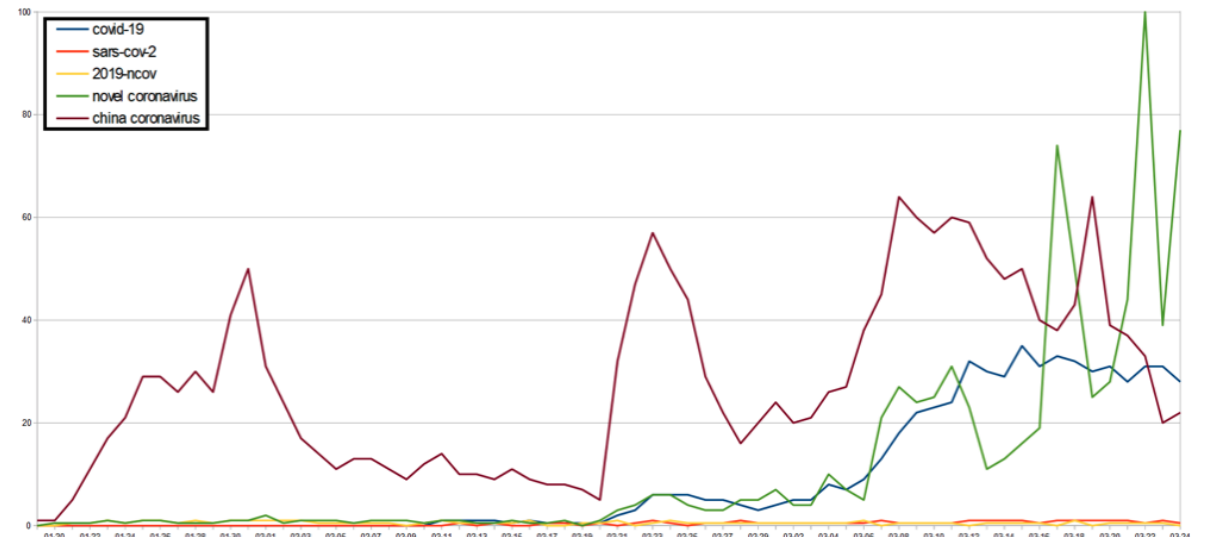
Figure 1. The top infodemic and scientific terms relating to coronavirus disease (COVID-19) trending in Italy.